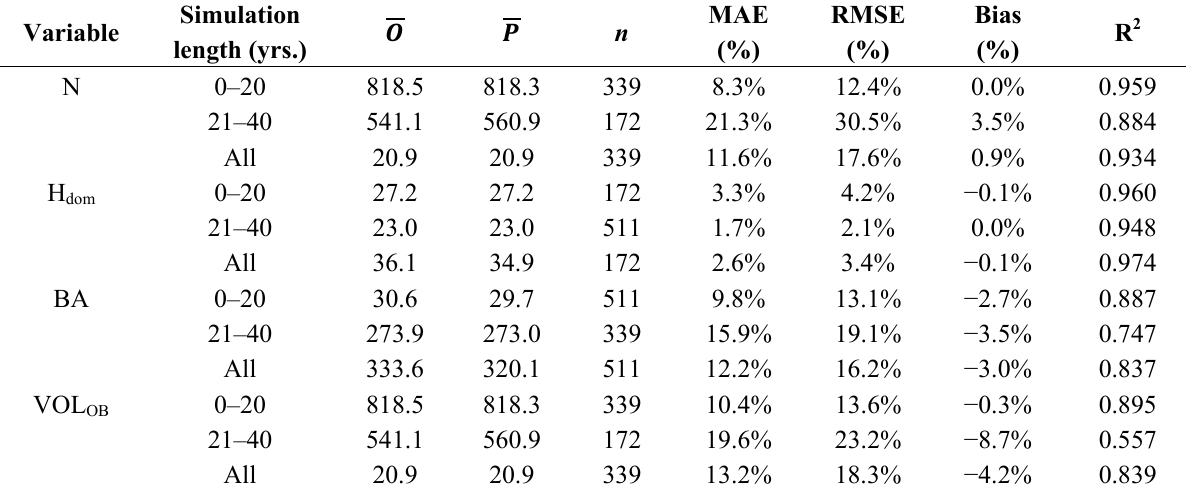
, BA and VOL dom MAE Bias